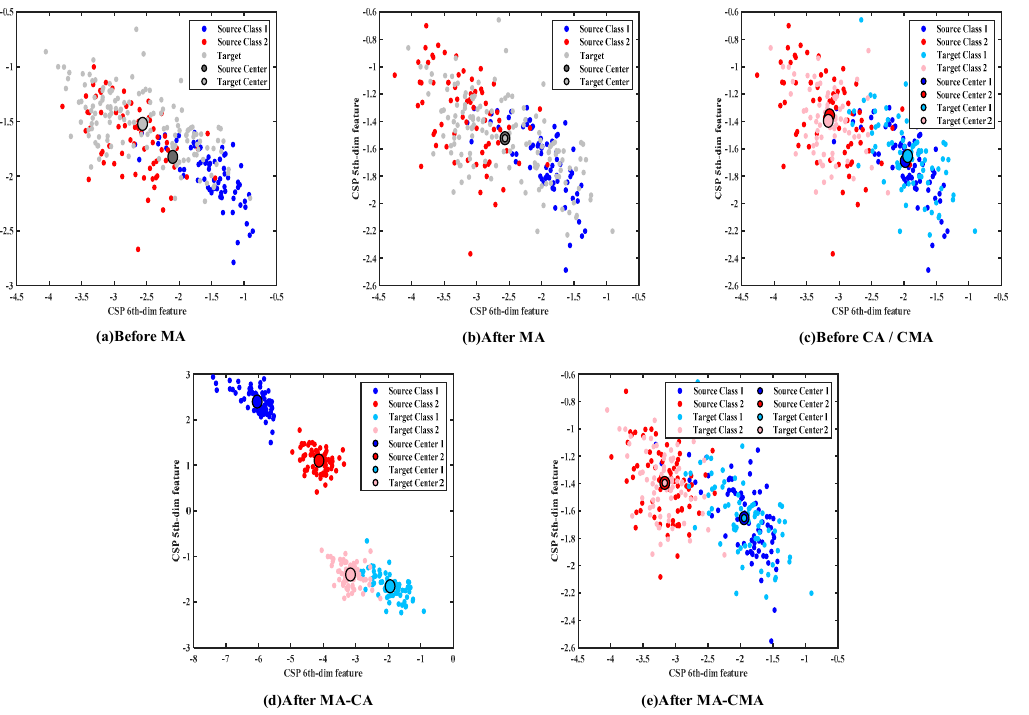
Figure 2. Visualization of data distribution during the alignment process for subject 3 on dataset 2. Data distribution ( a ) before MA, ( b ) after MA, ( c ) before CA/CMA, ( d ) after MA-CA, ( e ) after MA-CMA.